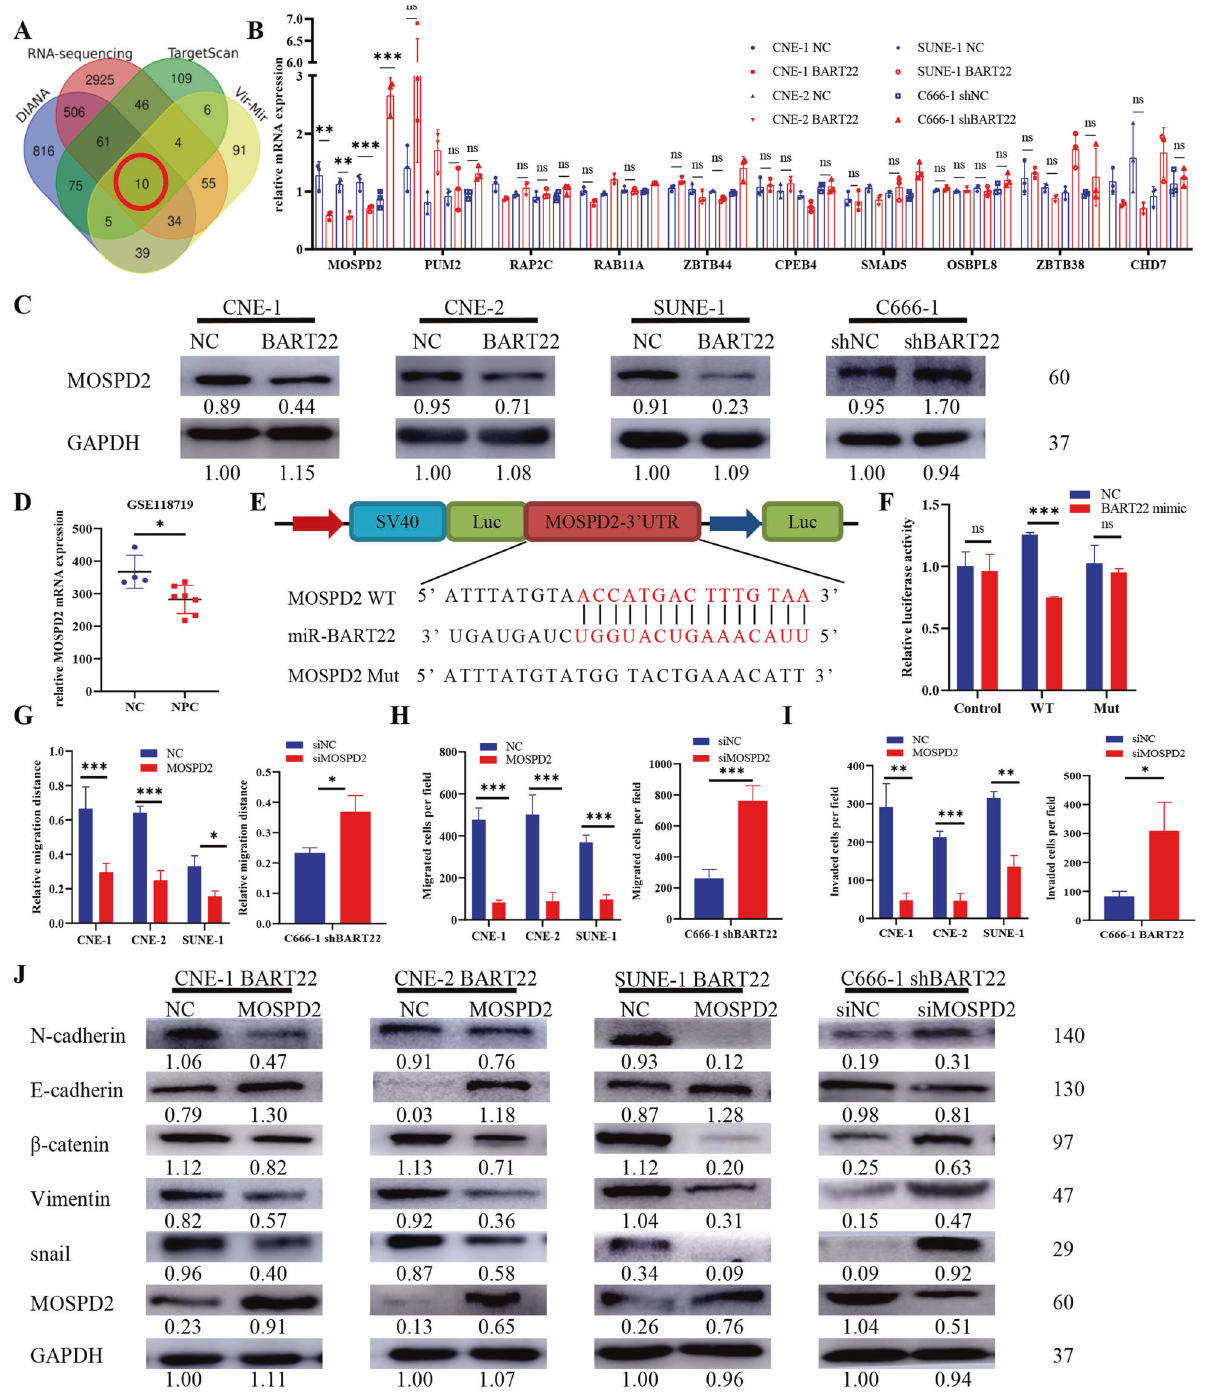
Fig. 7 MOSPD2 is a direct target of EBV-miR-BART22. A A Venn diagram depicting the overlap of target genes predicted by TargetScan (green), RNA-sequencing (red), DIANA (blue), and Vir-Mir (yellow). Putative target genes identi fi ed by this approach are listed. B Quantitative reverse transcription-polymerase chain reaction (qRT-PCR) analysis of EBV-miR-BART22 regulation on target genes in nasopharyngeal carcinoma cells. C Expression of MOSPD2 in indicated cells was examined by WB analysis. D The relative expression levels of MOSPD2 in normal nasopharyngeal tissues and nasopharyngeal tumors in the GEO data set for nasopharyngeal carcinoma. E The construction of luciferase reporter vectors with inserted WT or mutant MOSPD2 3 ′ -UTR sequences. F Changes in the normalized reporter gene activities of WT and mutant MOSPD2 3 ′ -UTR luciferase reporter constructs responded to the co-transfection of negative control (NC) or EBV-miR-BART22 mimic in T293 cells. G Representative photomicrographs of scratch wounds at 0 and 24 h after wounds were made. Quantitative measurement of wound gaps by Photoshop software. H Quanti fi cation of indicated migrating cells in 5 random fi elds analyzed by Transwell assays, respectively. I Quanti fi cation of indicated migrating cells in 5 random fi elds analyzed by invasion assays, respectively. J Expression of epithelial cell marker, mesenchymal cell marker, β -catenin, and MOSPD2 in indicated cells were examined by WB analysis. GAPDH was used as a loading control.